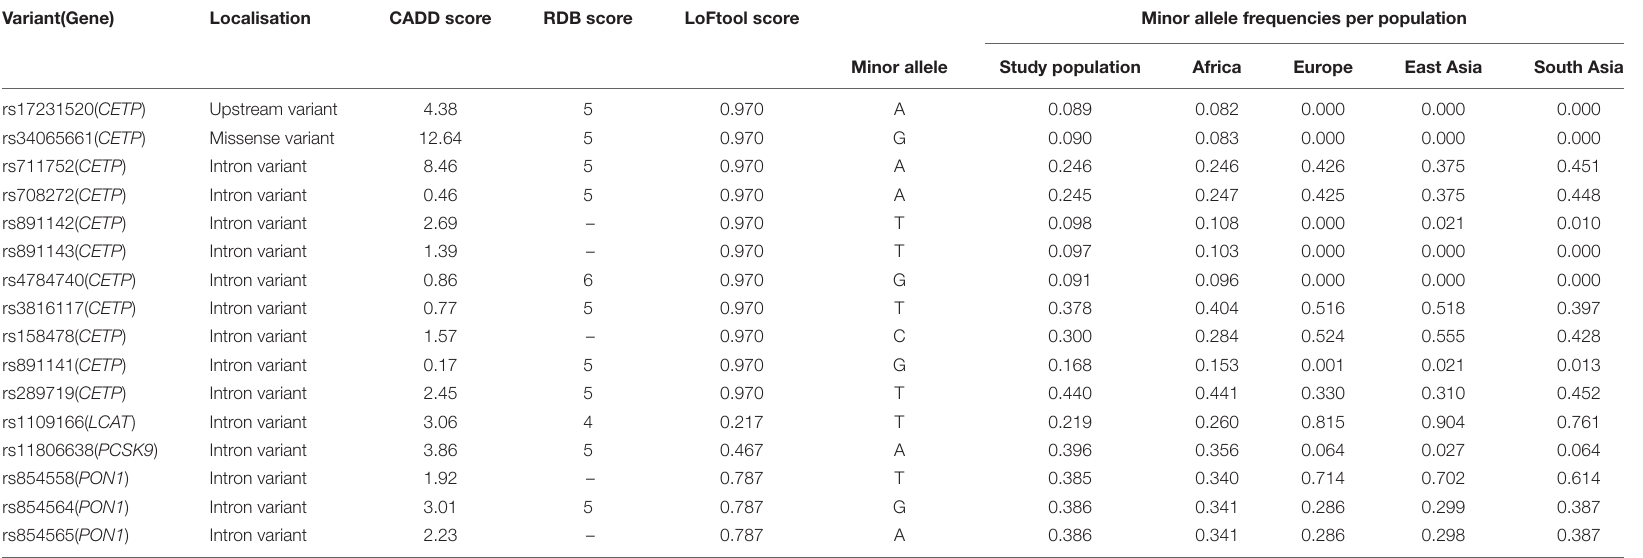
TABLE 4 | Functional annotations of lipid trait associated SNVs in Ghanaian adults and their minor allele frequencies in comparison to other population groups.